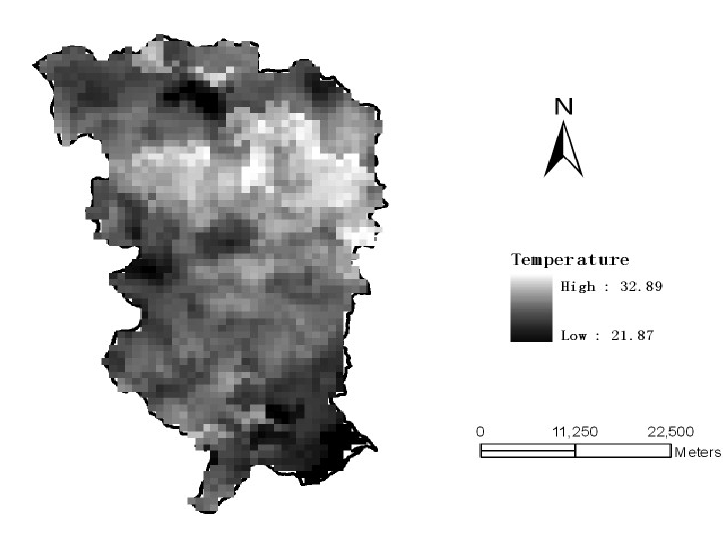
Figure 1. Temperature distribution (in ºC), Laiyang county (Shandong, China) at 10:20 pm on May 14 th , 2007 (MODIS).